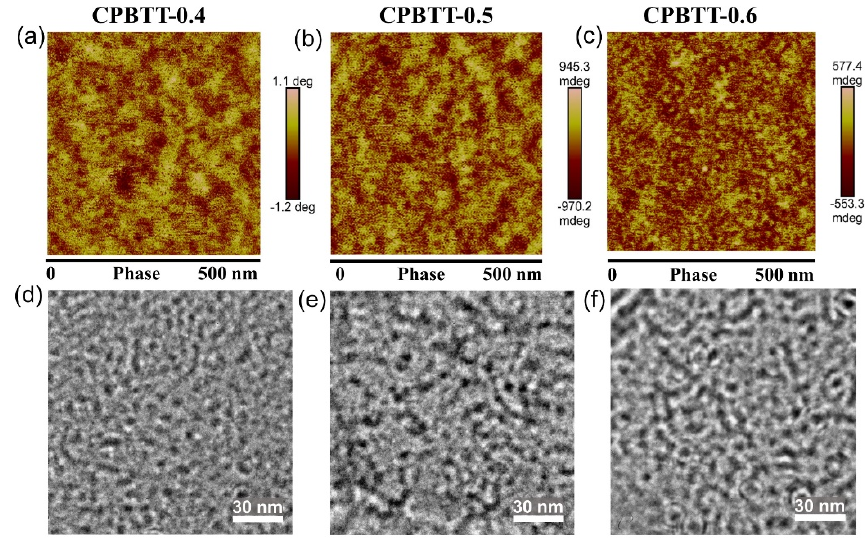
Figure 3. AFM phase images of the ( a ) CPBTT − 0.4, ( b ) CPBTT − 0.5 and ( c ) CPBTT − 0.6 AEMs. TEM images of the ( d ) CPBTT − 0.4, ( e ) CPBTT − 0.5 and ( f ) CPBTT − 0.6 AEMs.